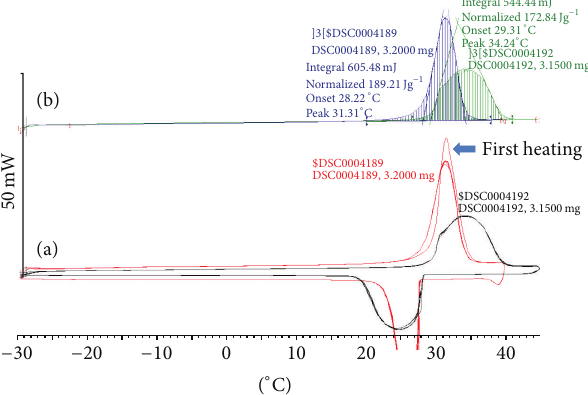
Figure 4: DSC curves of octadecane with (black) and without polymer coating (red) (a) and analysis of related curves